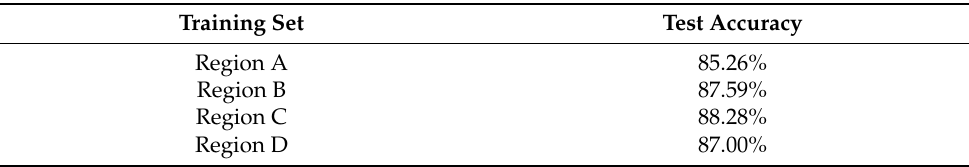
Table 7. Model test accuracy under different training